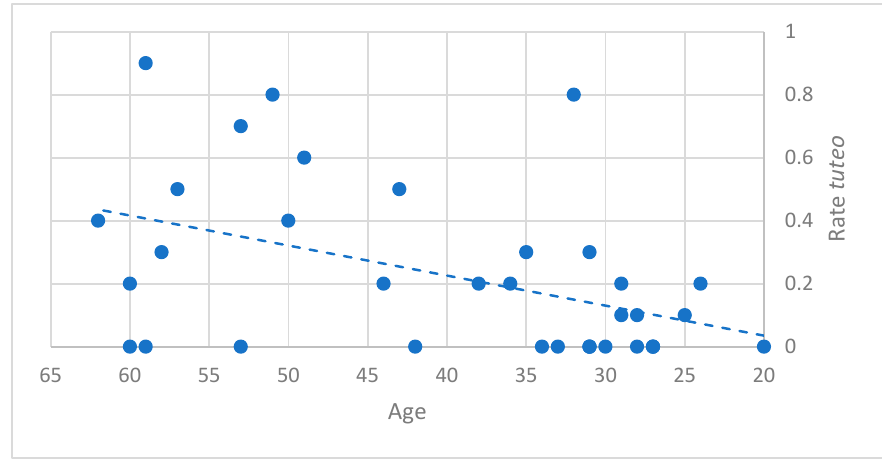
Figure 2. Rates of tuteo vs. voseo by age, demonstrating lowering rates of use over time.